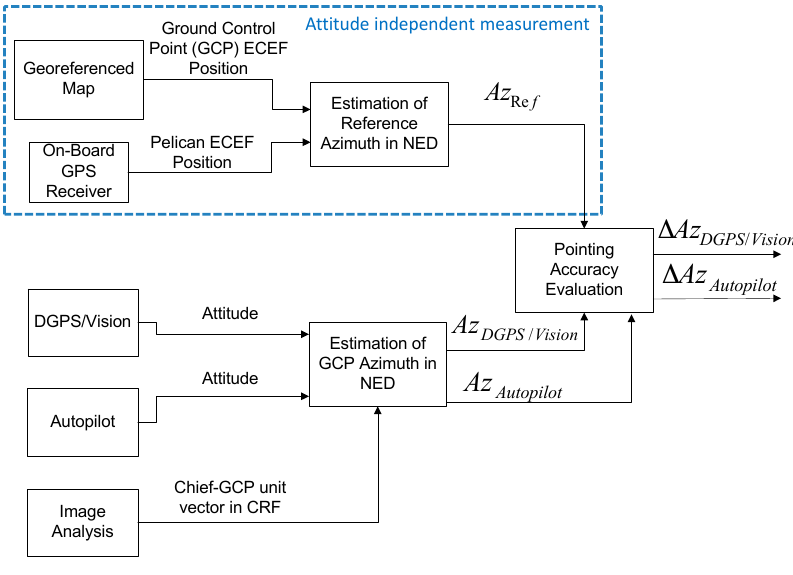
Figure 7. Pointing accuracy logical scheme.